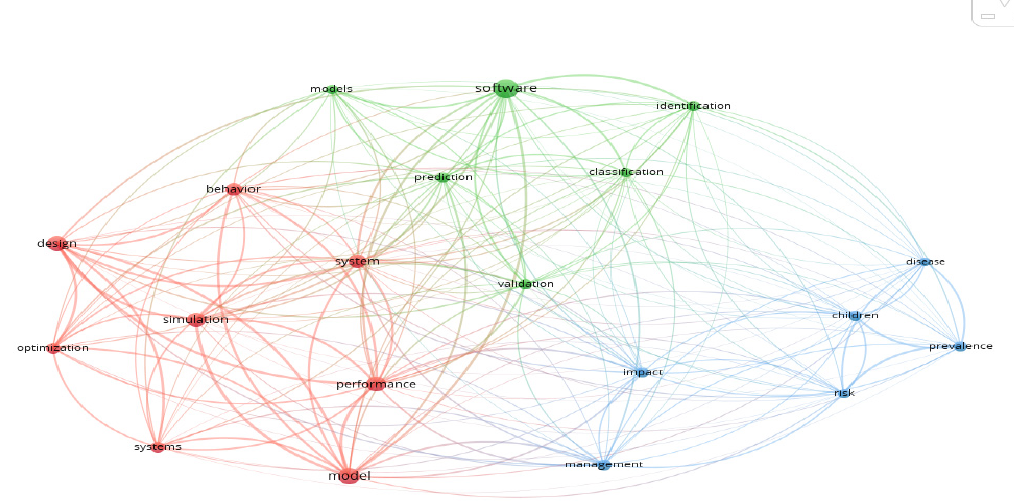
Figure 12. Word Cloud comprising top 50 most common words for the years 2016–2018.